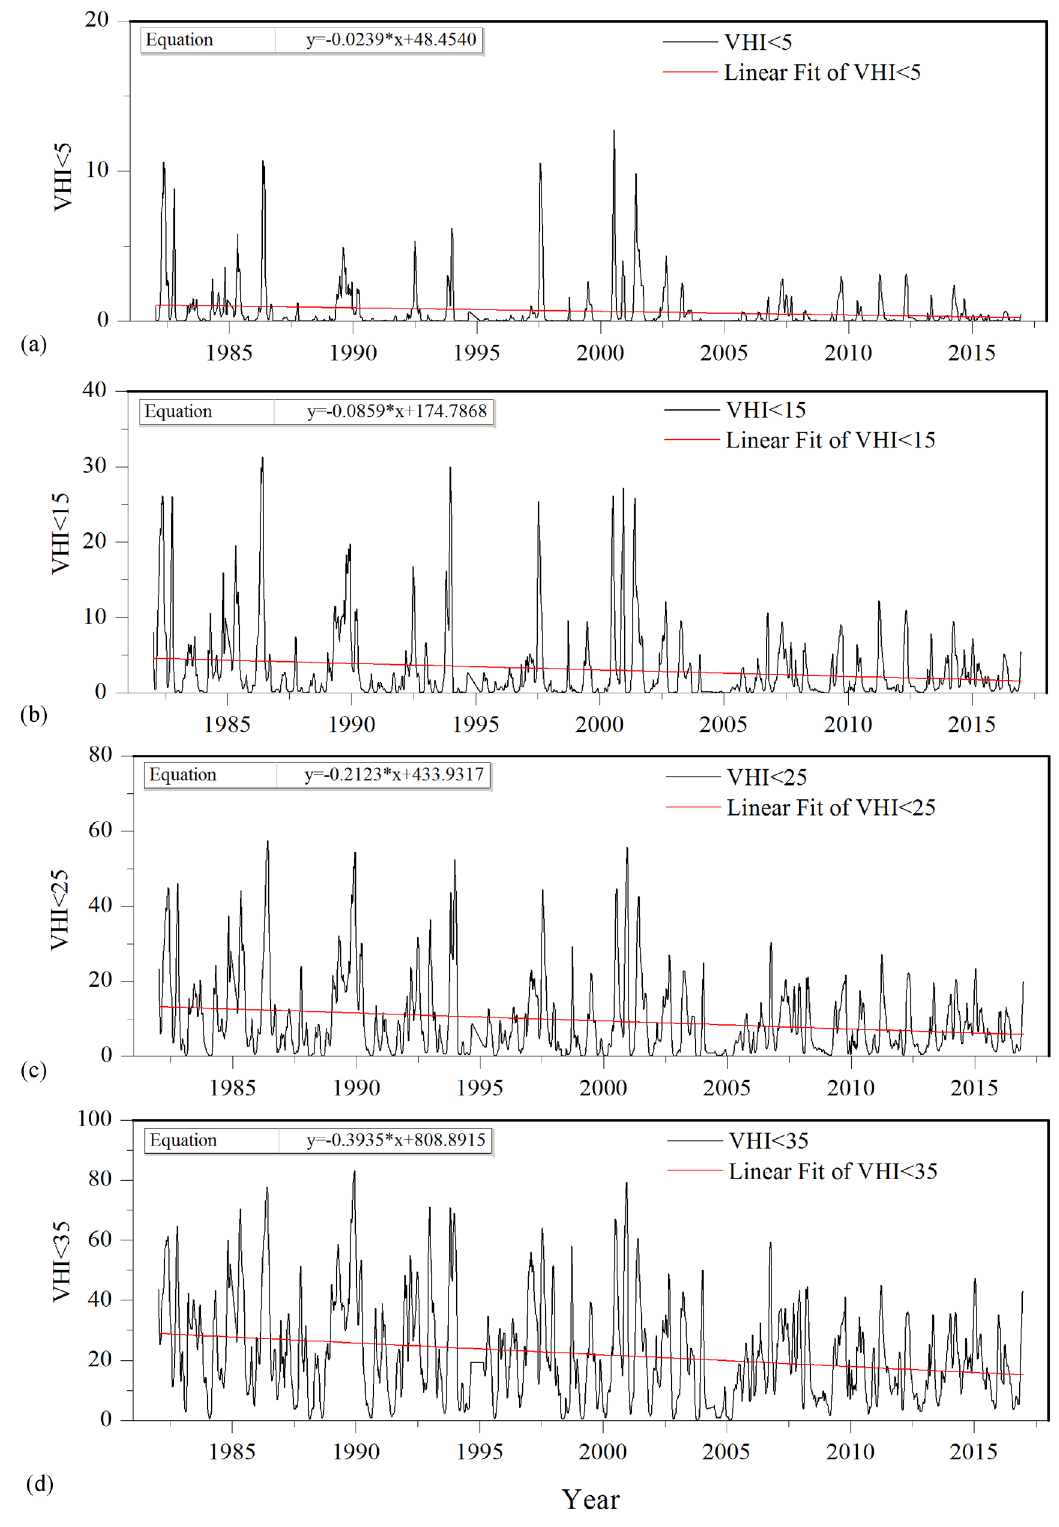
Figure 4. Percentage changes of area affected by drought at different intensities for the period of 1982–2016 in Jing-Jin-Ji region. ( a ) VHI < 5 indicates exceptional drought (D4); ( b ) VHI < 15 indicates extreme drought (D3); ( c ) VHI < 25 indicates severe drought (D2) and ( d ) VHI < 35 indicates moderate drought